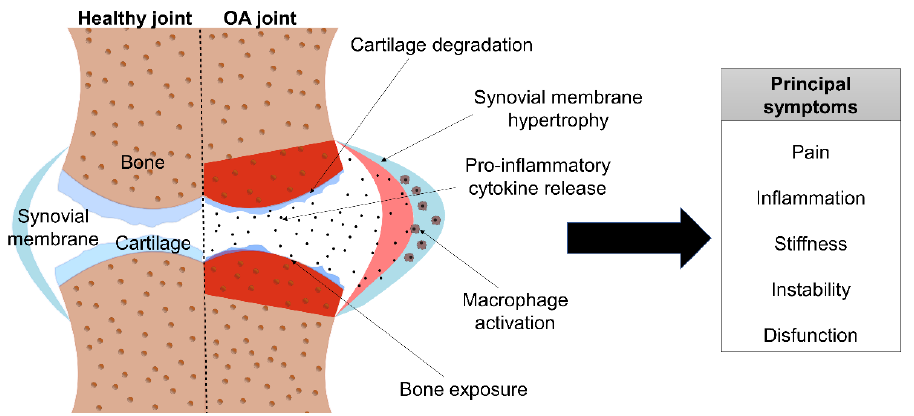
Figure 3. Schematic image of OA’s pathology and